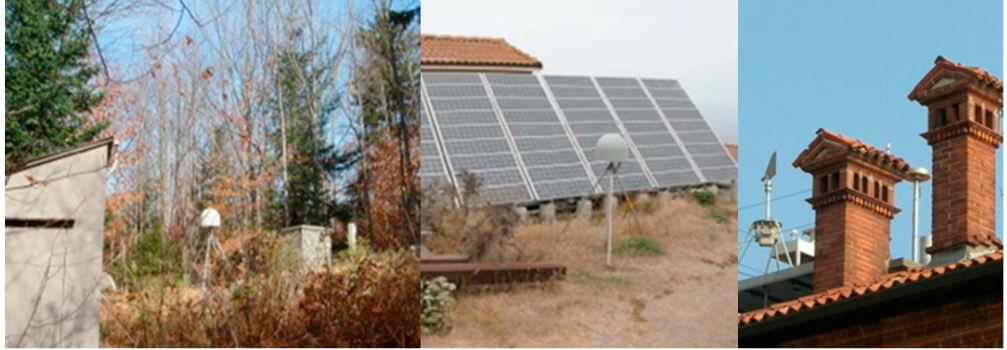
Figure 1. Examples of Poorly Sited CORS stations